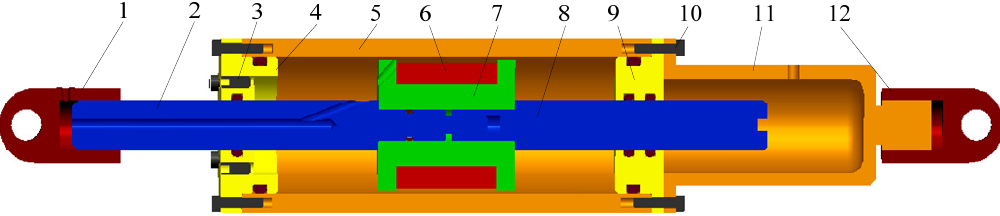
Figure 1. Schematic diagram of MR damper. (1) Left lifting lug, (2) left piston rod, (3) injection hole screw, (4) left end cover, (5) cylinder, (6) excitation coil, (7) piston head, (8) right piston rod, (9) right end cover, (10) end cover screw, (11) end shield, (12) right lifting lug.